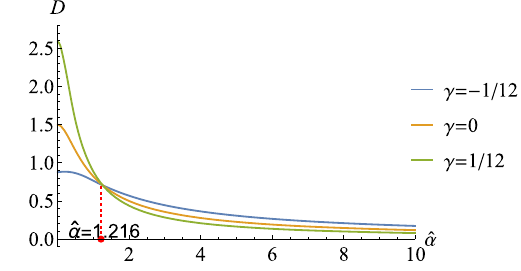
fixed Weyl coupling parameter γ . (For interpretation of the references to color in this figure, the reader is referred to the web version of this